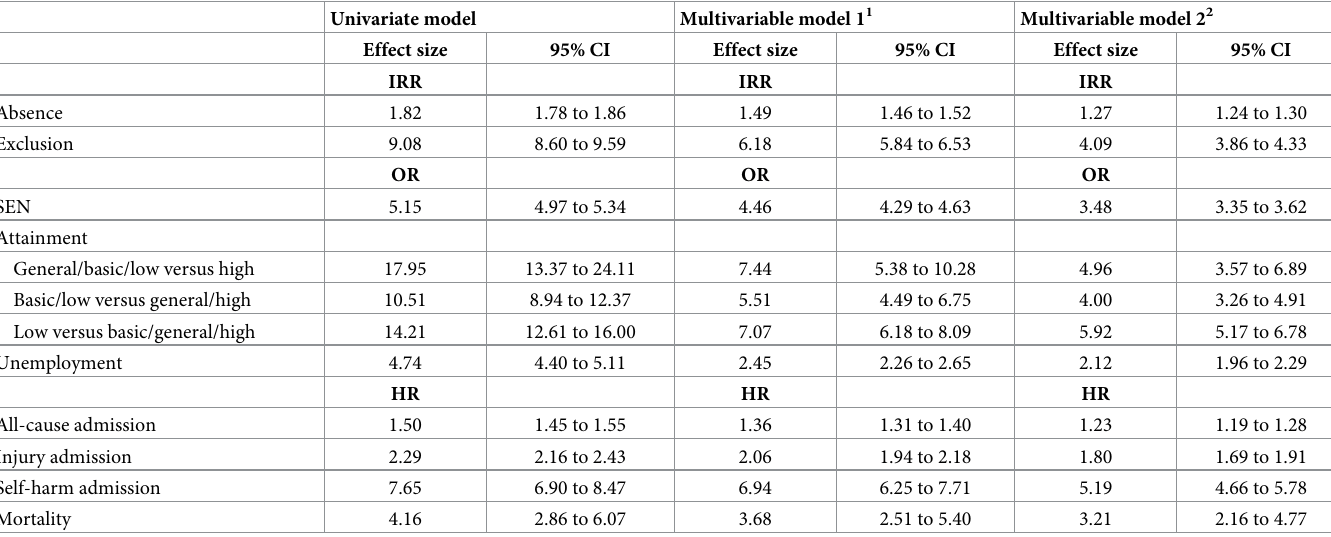
Table 2. Association between being looked after at school and educational and health